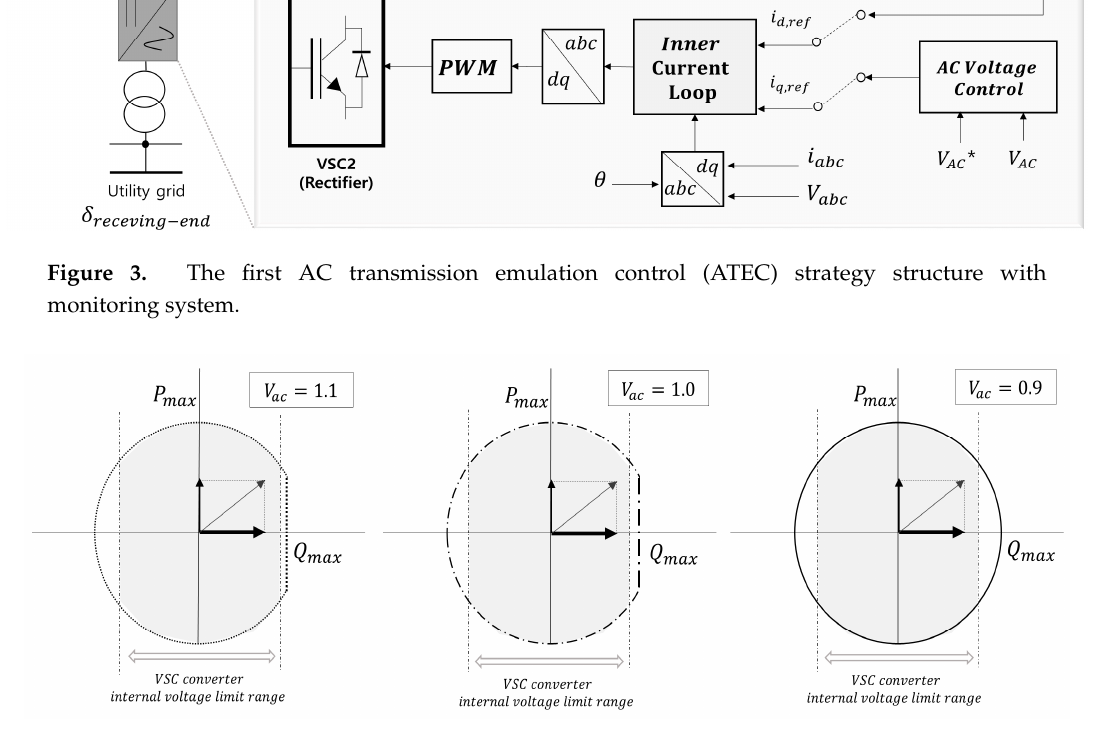
Figure 4. Operation capability of the first ATEC strategy.